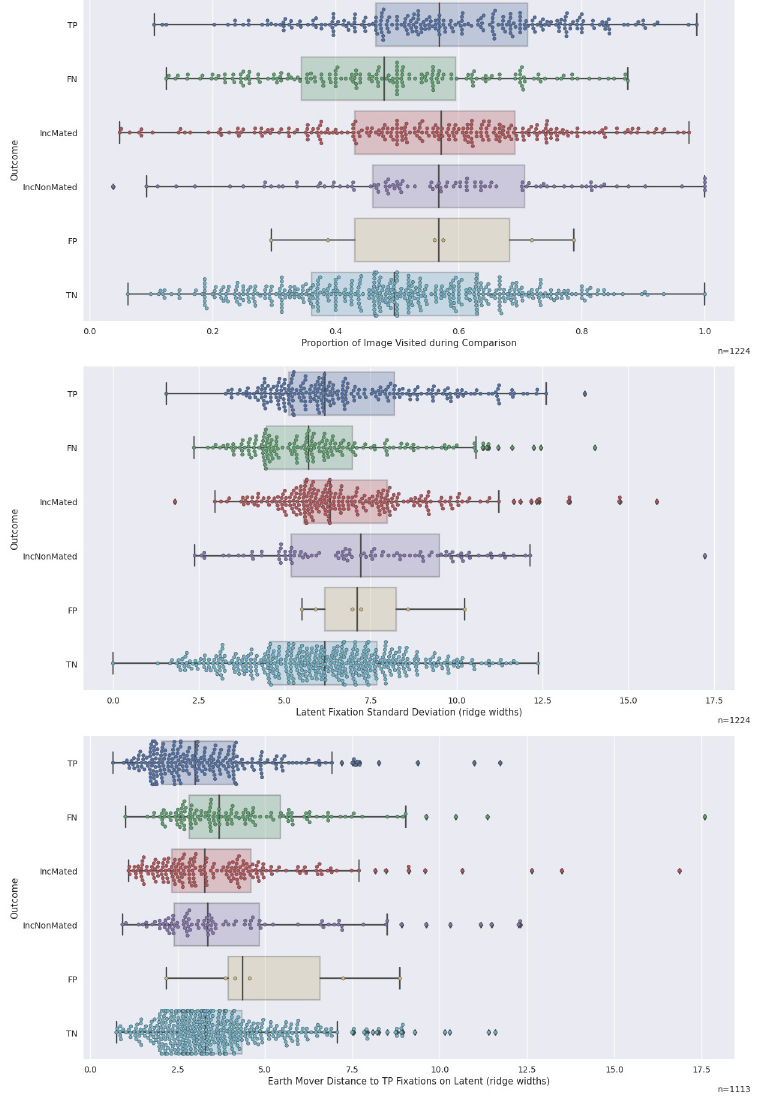
Fig 8. Boxplots of various metrics for each outcome. Upper panel: Proportion of Image Visited. Middle panel: Latent Fixation Standard Deviation. Lower panel: Earth Mover Distance.